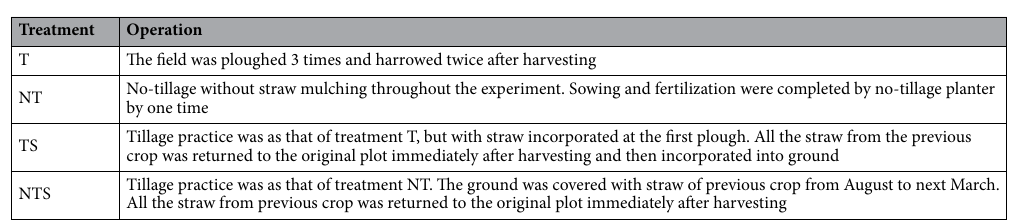
Table 3. Description of treatments of the experiment.